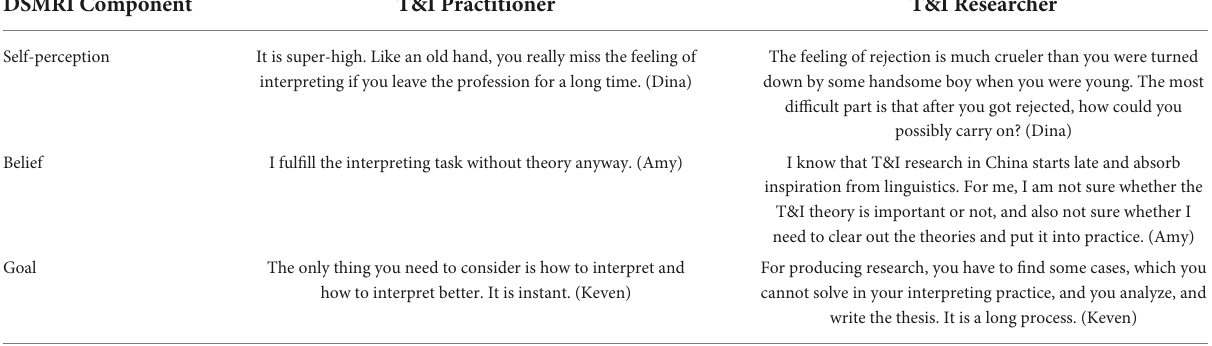
TABLE 2 Misalignment between T&I practitioner and researcher roles. DSMRI